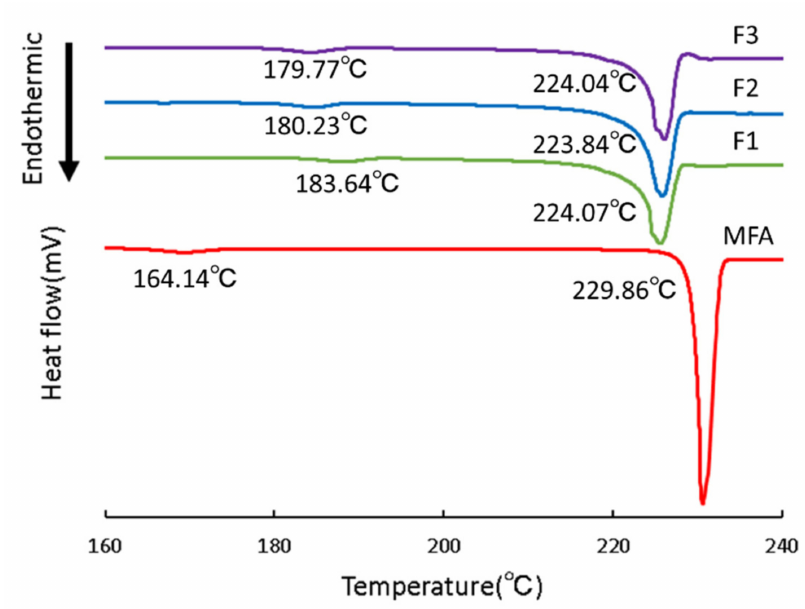
Figure 3. DSC curves of MFA crystals, F1, F2, and